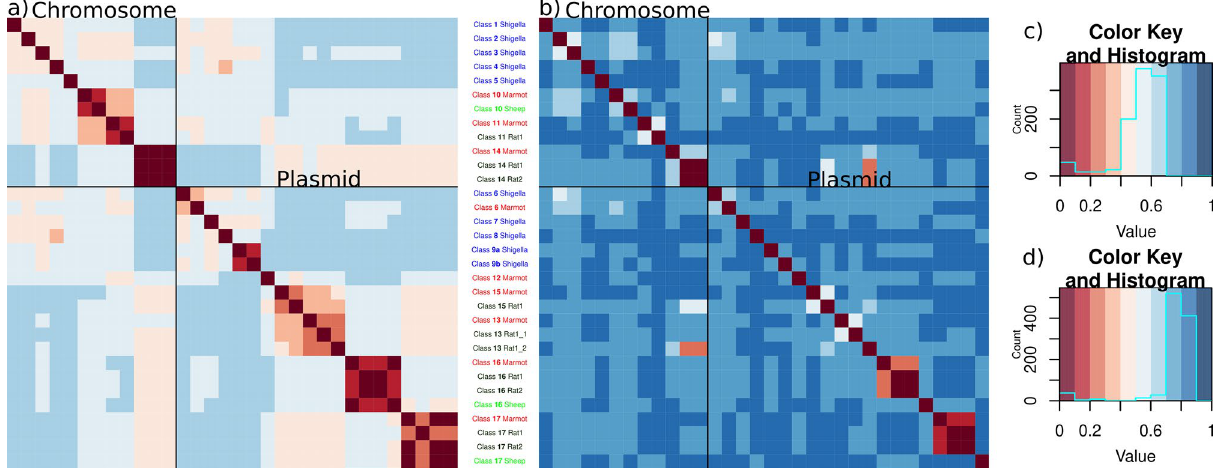
Figure 5. Heatmap of the pairwise distances and the corresponding color keys of ( a , c ) the ipaH genes; ( b , d ) their upstream sequences in non-human-host Escherichia spp. Hosts are labeled according to the following principle: marmot is marked by red, rat is marked by dark green, sheep is marked by light green. Representative sequences of Shigella ipaH genes also were included in comparison, their labels marked in blue. Pairwise 1 − identity distances were calculated as (cid:31) . (cid:30) (cid:29)